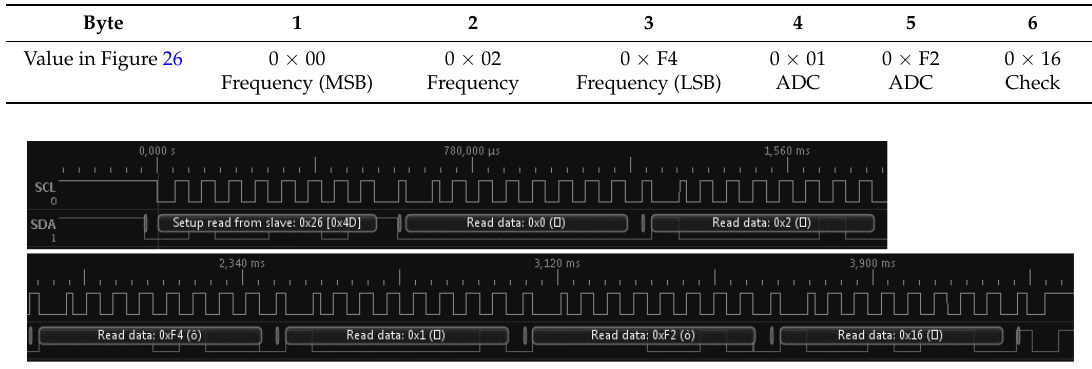
Figure 26. Probe’s reply to the sample acquisition request.